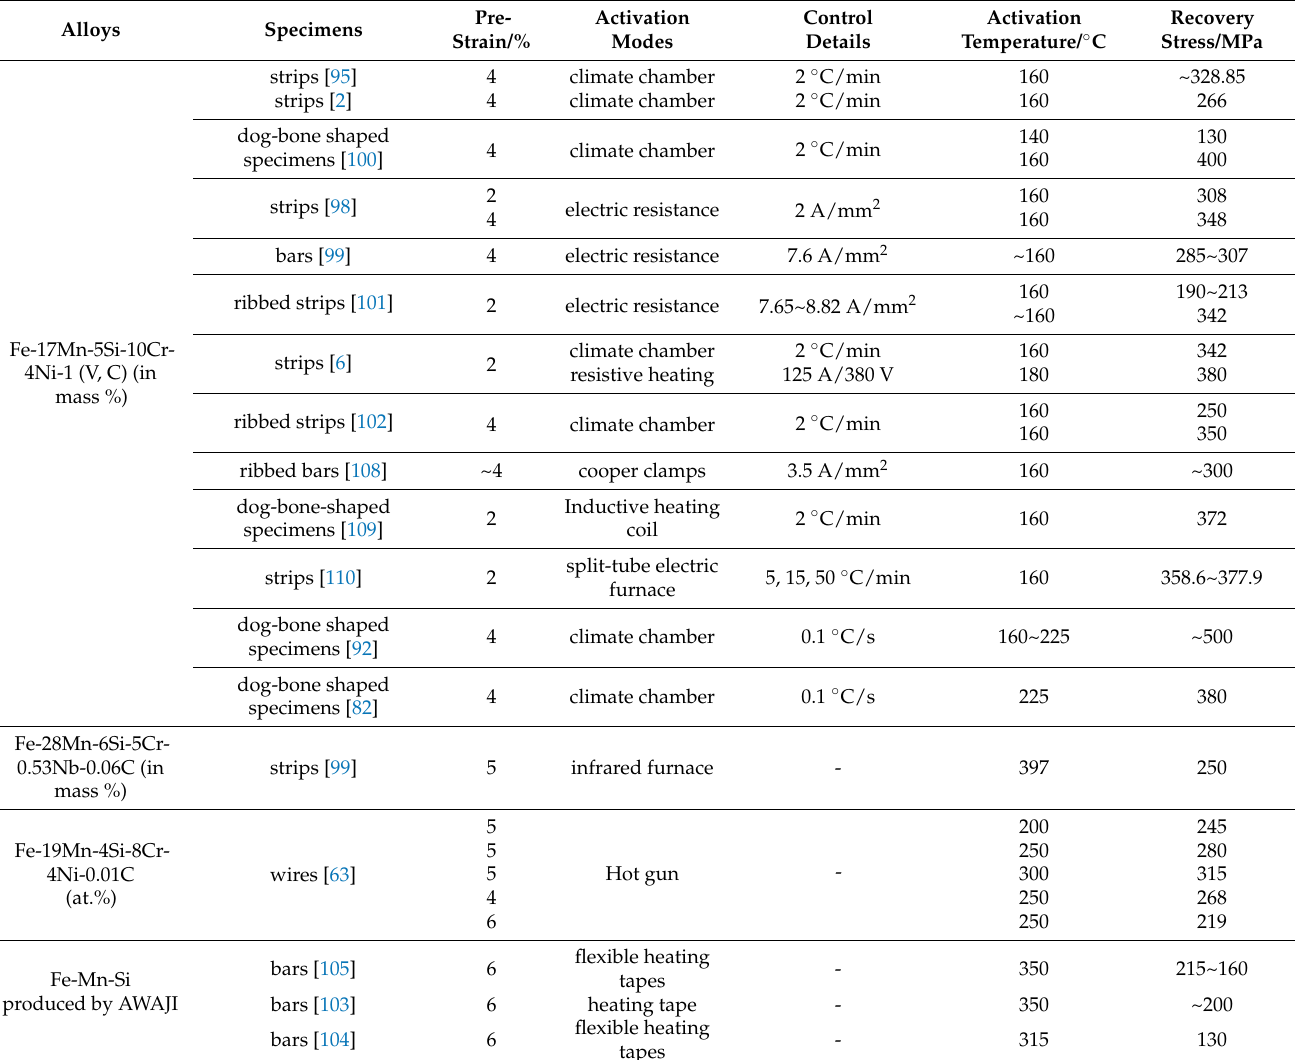
Table 4. The available activation mode and recovery stress of